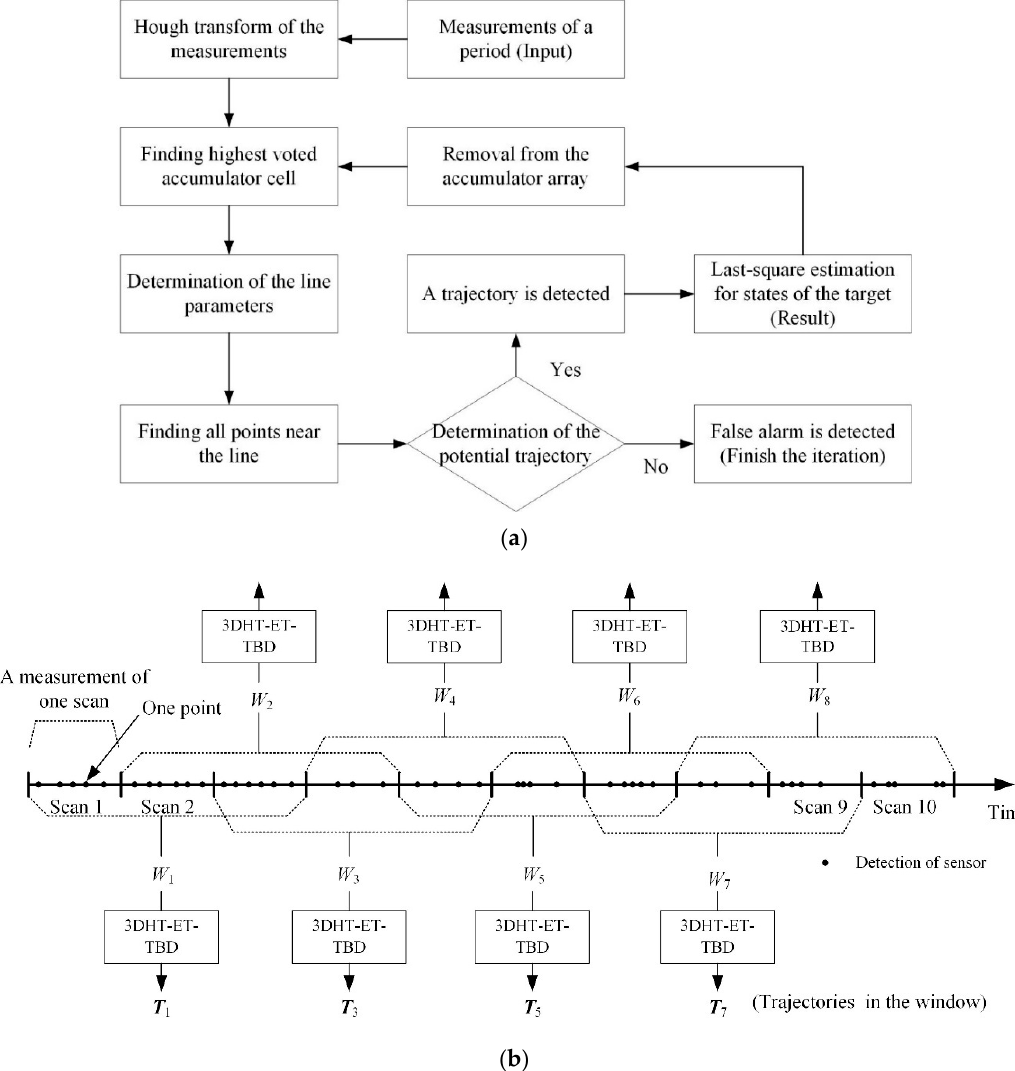
Figure 2. ( a ) The roadmap of the 3DHT-ET-TBD method. ( b ) The application of the 3DHT- ET-TBD method in multiple extended target tracking